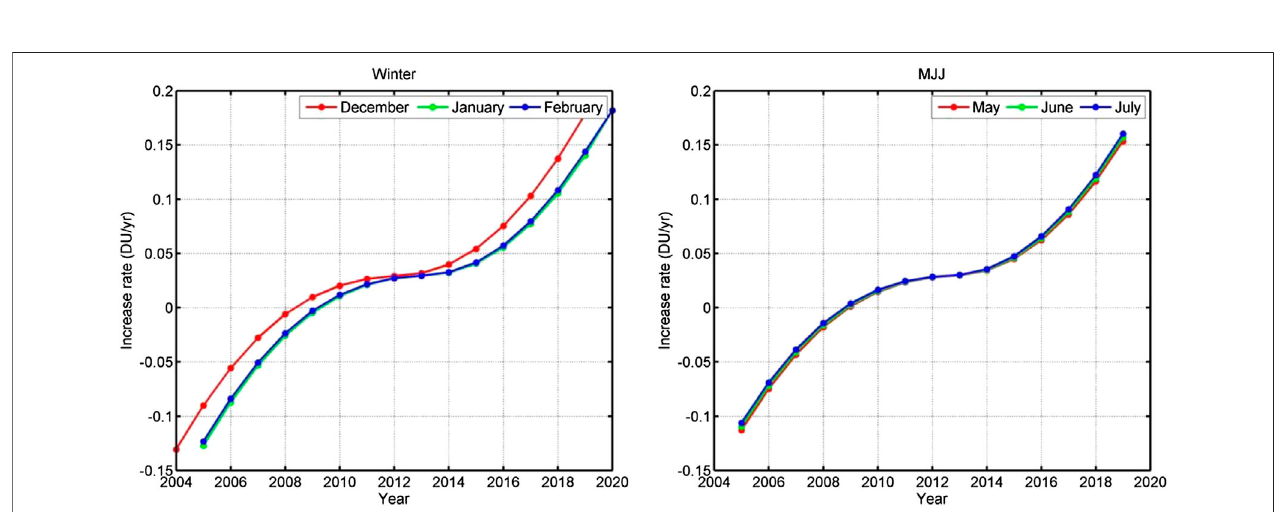
FIGURE 8 | Trend of ozone de fi cit over the TP in winter (left) and early summer (right).